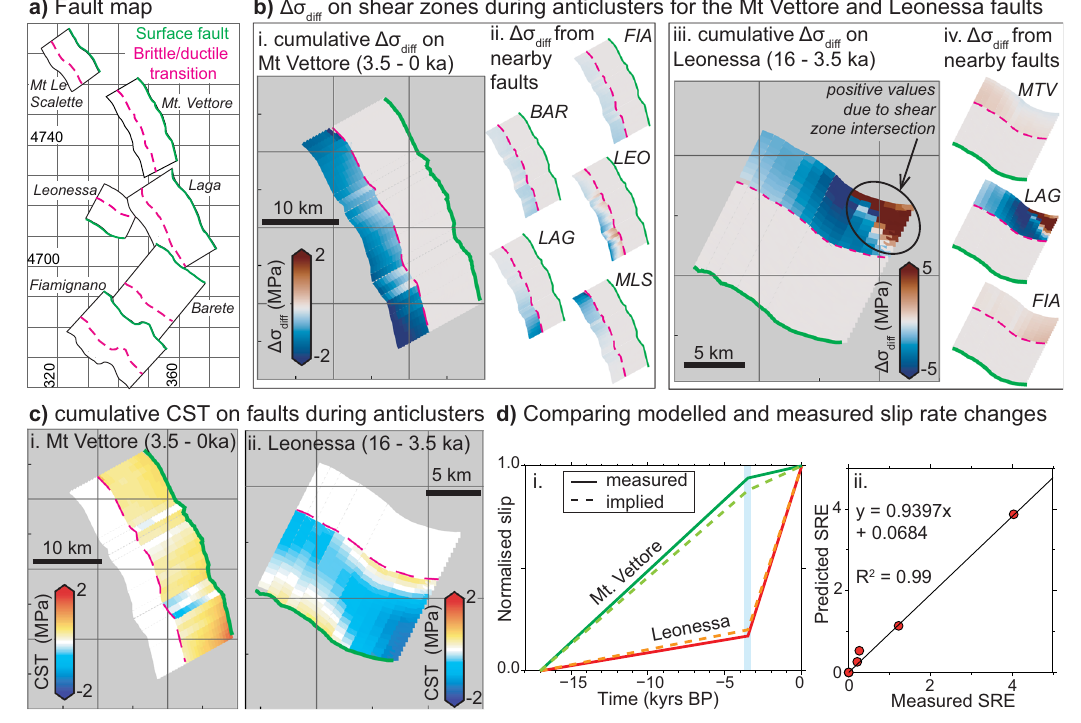
Fig.6|Stresschangesandeffectsonslipratesduringperiodsofquiescencefor theMt. Vettoreand Leonessa faults. a Fault mapshowing the locationsofthe six faultsstudied. b Cumulativedifferentialstresschanges( Δ σ diff )duringanti-clusters. (i)OntheMt.Vettoreshearzone,whichisthesumof(ii)contributionsfromnearby faults. (iii) Onthe Leonessa shearzone,whichis the sum of (iv)contributions from nearby faults, except the Mt. Le Scalette and Barete faults because Δ σ diff are neg- ligible (<±0.05 MPa). The periods of quiescence are shown in the slip histories in Figs.4and5. c CumulativeCoulombStressTransfer(CST)onthe(i)Mt.Vettoreand (ii) Leonessa faults during the studied anti-clusters. d Comparison between